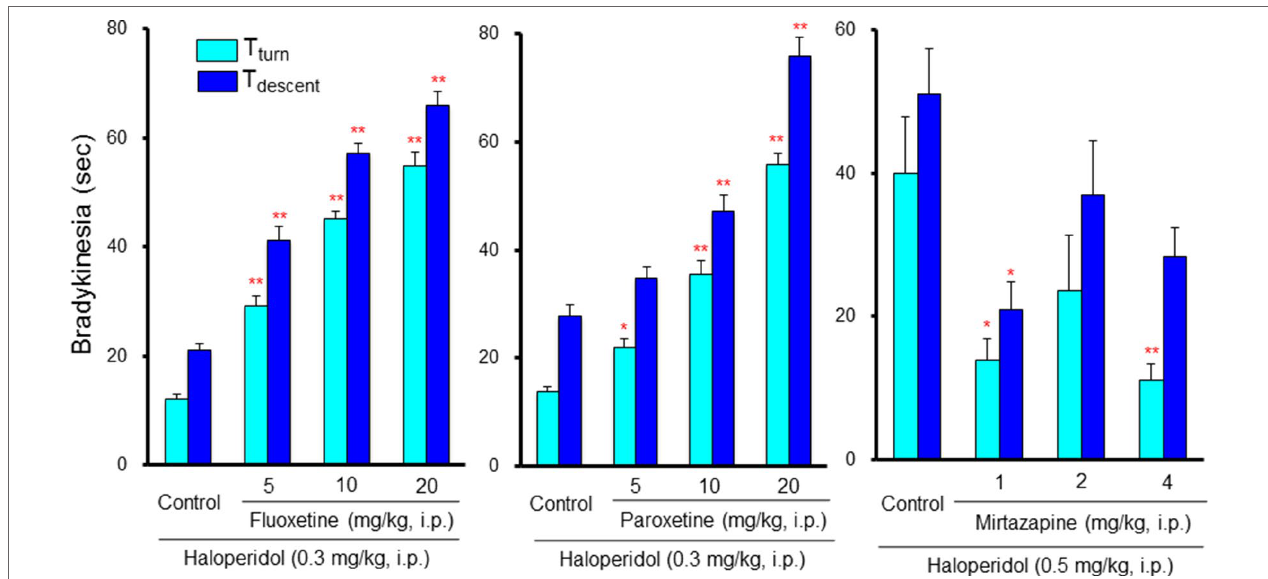
FIGURE 7 | Interactions between antidepressants and antipsychotics in induction of extrapyramidal side effects (EPS). Bradykinesia was estimated by the pole test as described in Figure 6 legend. Although low dose (0.3 mg/kg) of haloperidol showed only weak effects in the pole test, combined treatment with selective serotonin reuptake inhibitors, fluoxetine and paroxetine, markedly potentiated haloperidol-induced bradykinesia in a synergistic manner. By contrast, the tetracyclic antidepressant mirtazapine, which possesses α 2 , 5-HT 2 and 5-HT 3 antagonistic actions, reduced bradykinesia induced by a moderate dose (0.5 mg/ kg) of haloperidol. * P <0.05, ** P ,0.01; Significantly different from the control values. This figure is quoted and arranged from Prog. Neuro-Psychopharmacol. Biol. Psychiatry 38, 252,